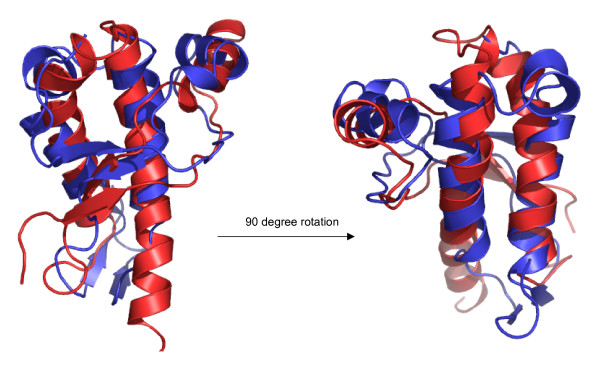
3D representation of Structural Alignment. 3D structural representation of the optimally aligned structures of PrP (red) and Dpl (blue).